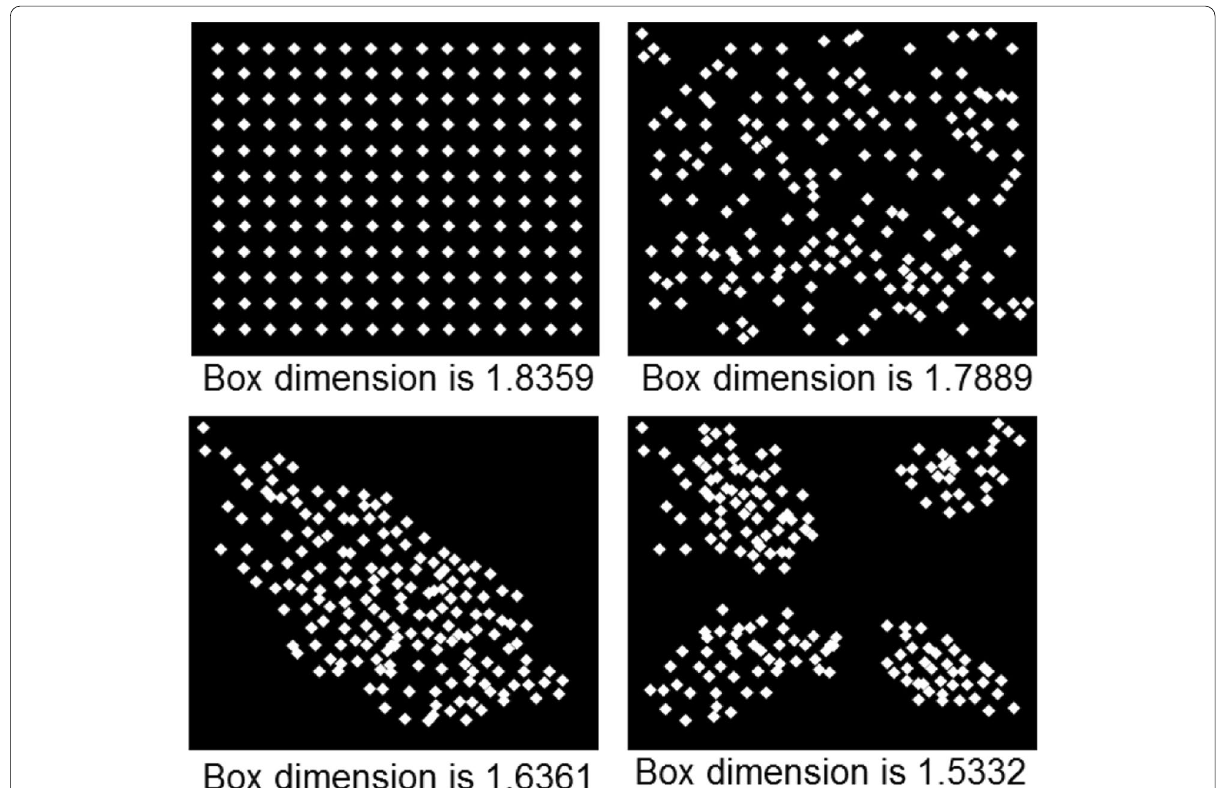
Fig. 4 Graphic explanation of the relation between box dimension and particles distribution